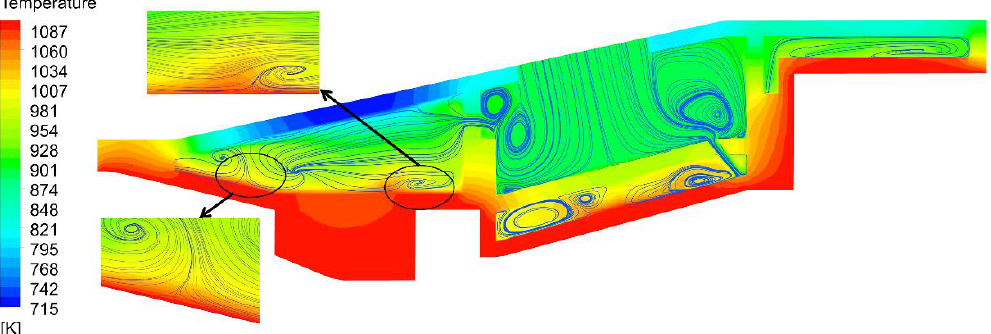
Figure 7. Combination of the flow and temperature contour of the X – Z section in the open